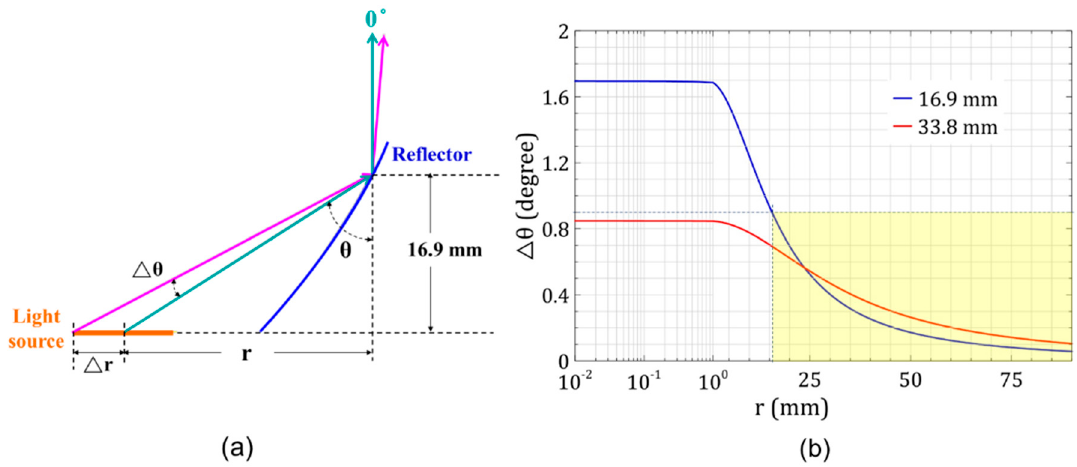
Figure 5. ( a ) Schematic of the reflector when controlling the divergence angle and ( b ) plot of the half divergence angle versus the radius of the reflector.